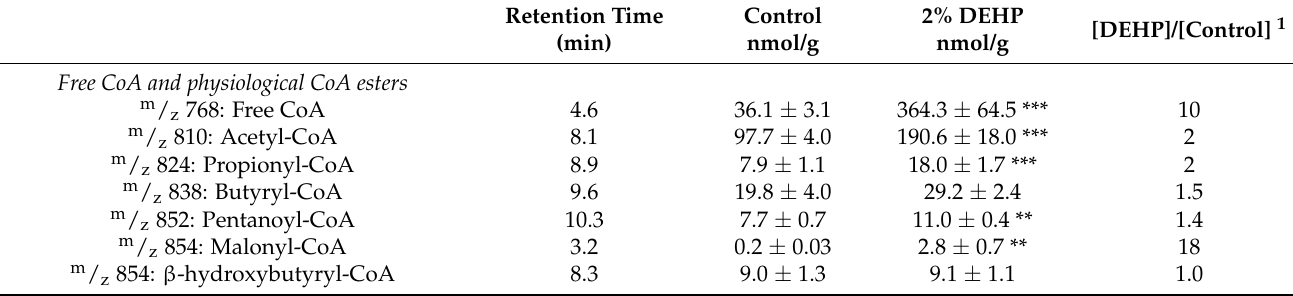
Table 1. Relative concentrations of free CoA and CoA esters identified by the M-507 transition during LC-MS/MS analysis of livers from control and DEHP exposed rats ( n = 7 per group) (nmol/g or nmol/g tissue). Because labeled internal standards are not available for most analytes, the data were calculated as relative concentrations compared to an internal standard of [ 2 H 9 ]pentanoyl-CoA means ± s.e.m. Thus, relative concentrations of different CoA esters may not be added to estimate the total pool of CoA. However, in the 1st section of the table (free CoA and physiological CoA esters), the ratios of relative concentrations [DEHP]/[Control] in the last column represent valid variations in the liver content of the corresponding analyte. The 2nd section of the table lists four C 8 physiological CoA esters and some DEHP-derived CoA esters which are isobars with the same retention times as the four C 8 physiological CoA esters. In this section, the m / z 892 and 910 could be any of two or three DEHP-derived CoA esters, respectively. The 3rd section of the table lists unidentified CoA esters in Control livers which are isobars with the same retention times as unidentified CoA esters in livers from DEHP-treated rats. Note that in the 2nd and 3rd section of the table, CoA esters listed under 2% DEHP probably include CoA esters listed under Control. Thus, the high [DEHP]/[Control] ratios in the last column reflect the likely formation of unknown DEHP-derived CoA esters. *, **, *** denote significant difference relative to Control at: p < 0.05, p < 0.01, p < 0.001, respectively.